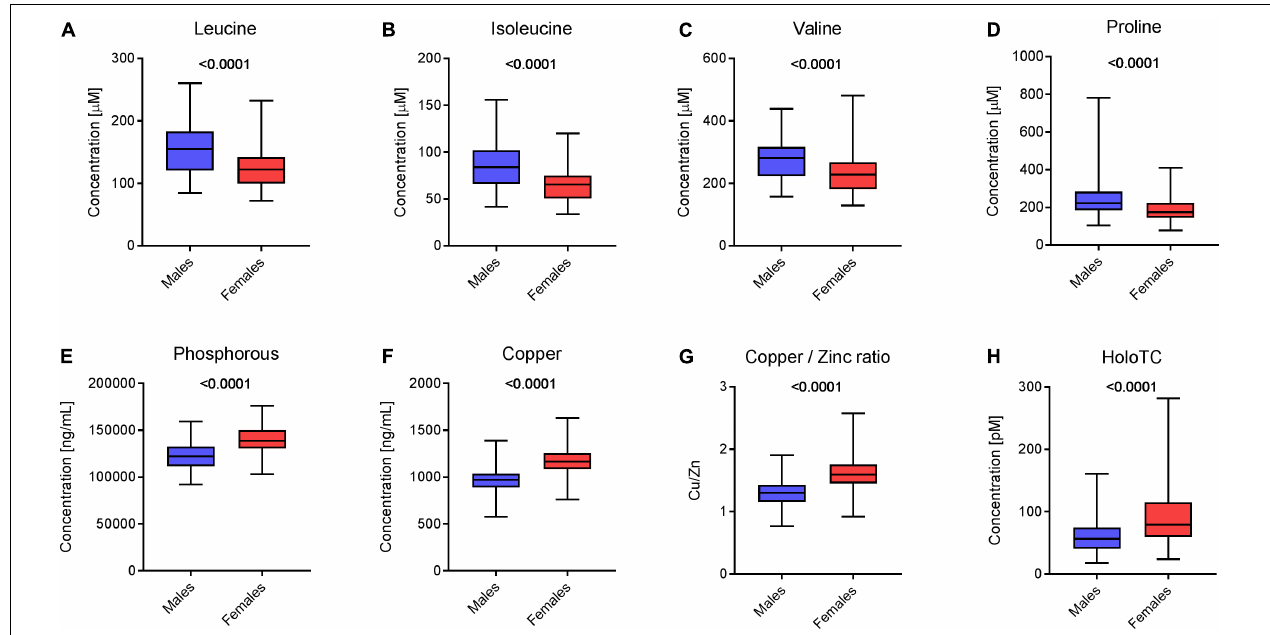
FIGURE 3 | Sex-specific differences in blood nutrients. Box plots representing the concentration of selected blood nutrients in male and female populations ( N = 83 males and 93 females). Statistics with an unpaired Student’s t -test ( p -value is depicted above the box plot). Concentration of (A) leucine, (B) isoleucine, (C) valine, (D) proline, (E) phosphorus, (F) copper, (G) the ratio between the concentrations of copper and zinc and (H ) holotranscobalamin II in the two populations. TABLE 3 | Summary of statistical characteristics of BC and BNP OPLS models. Male subjects Female